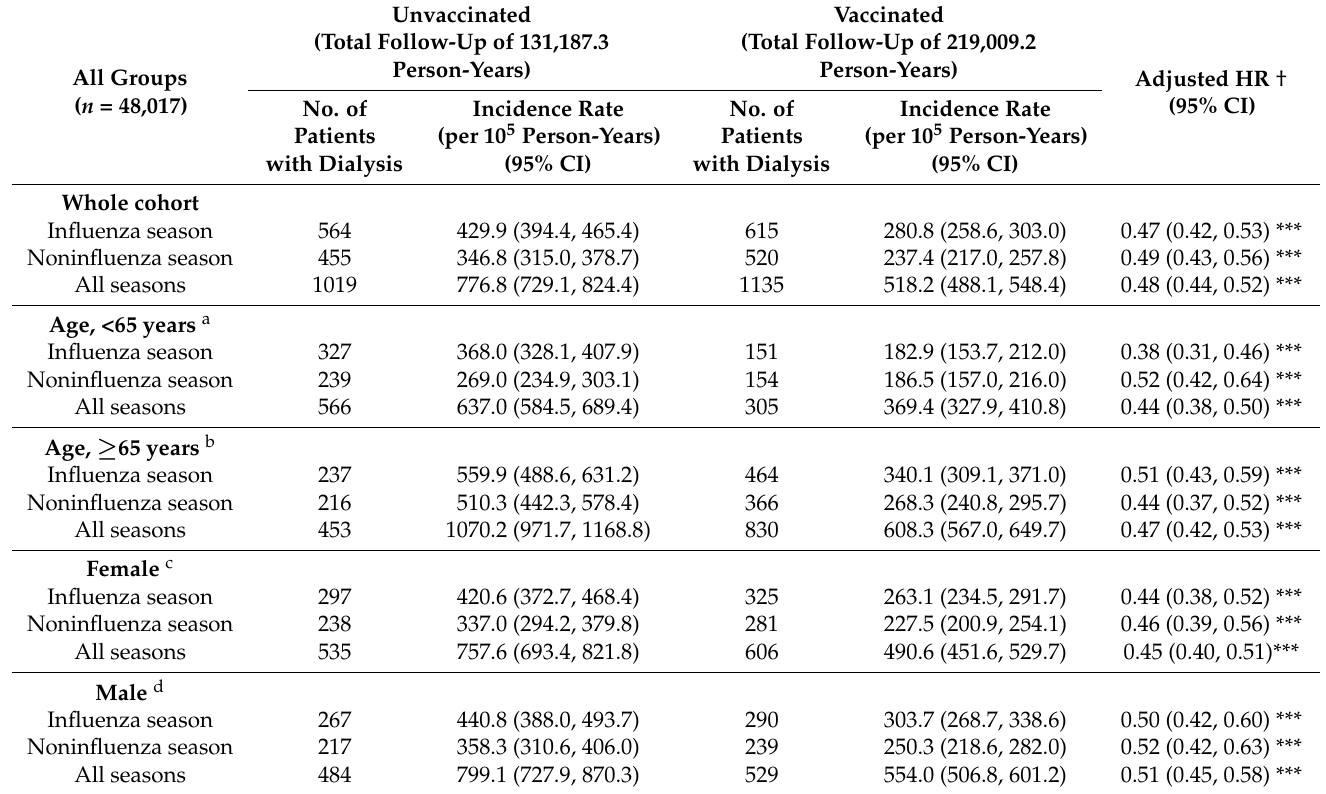
Table 3. Risk of Dialysis in the Unvaccinated and Vaccinated Patients in the Study